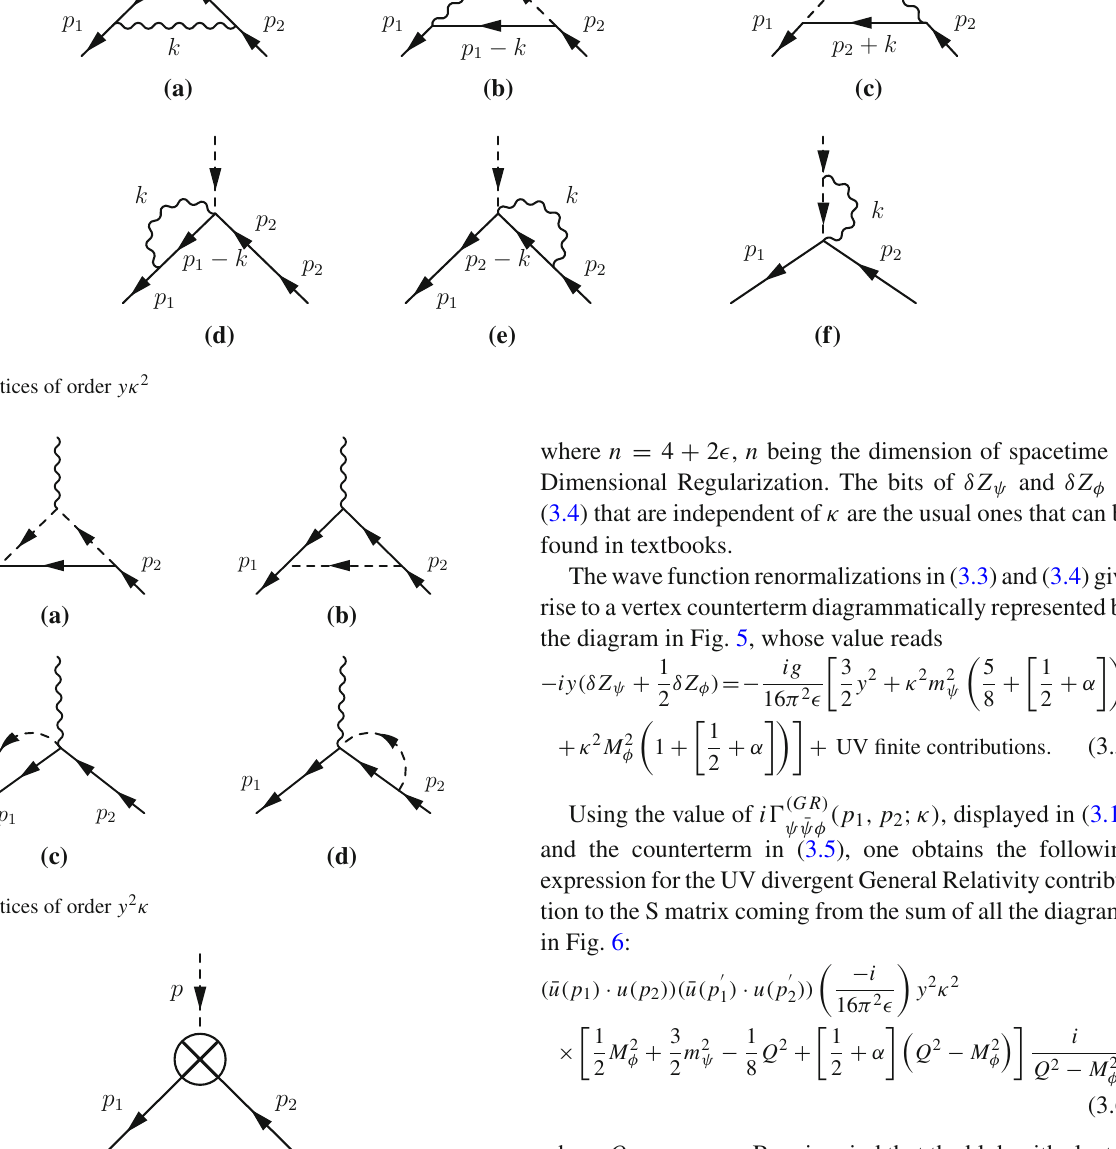
Fig. 5 Counterterm y κ